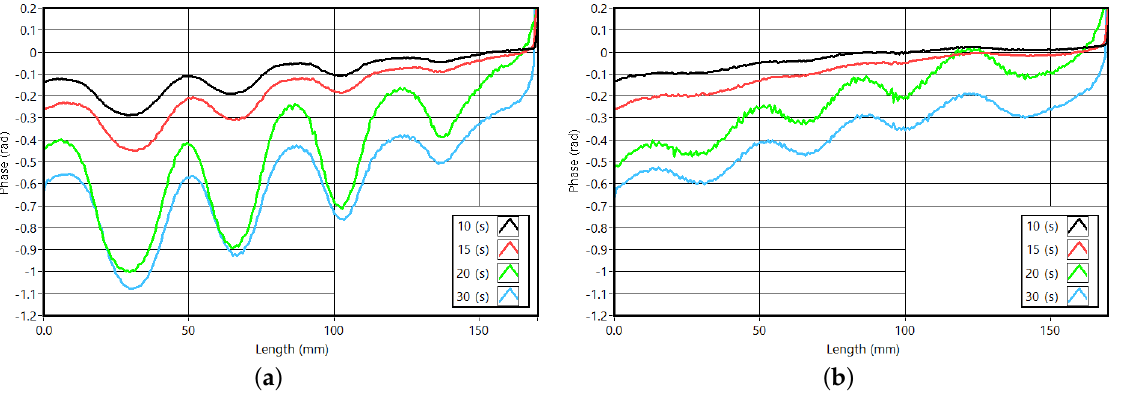
Figure 20. Vertical phase profiles for two rows of slots of the CFRP samples and various cycle periods. ( a ) Phase profiles for the slots 2 mm thick. ( b ) Phase profiles for the slots 4 mm